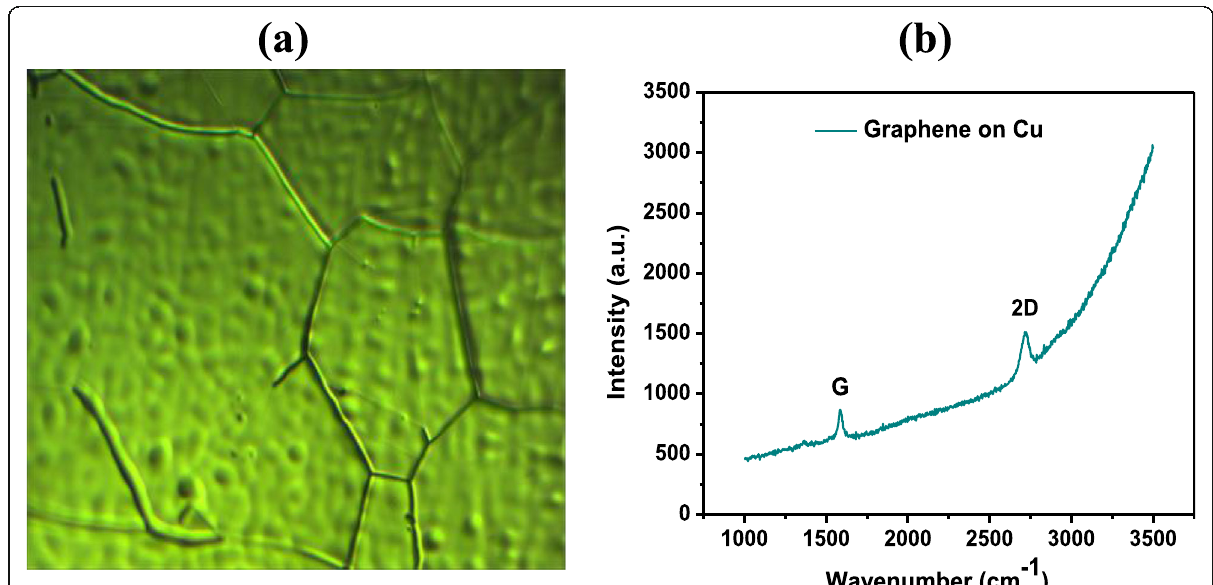
Fig. 1. a Optical micrograph of CVD-grown graphene on Cu. b Raman spectroscopy of CVD-grown graphene on